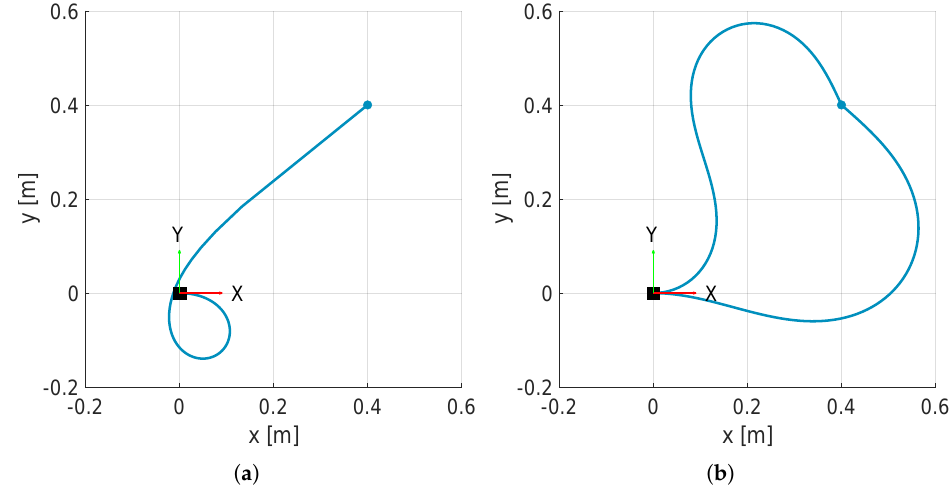
Figure 4. ( a ) Deformed shape for buckling mode 1. ( b ) Deformed shape for buckling mode 2. Both correspond to a clamped-pinned rod for a given end-tip position.